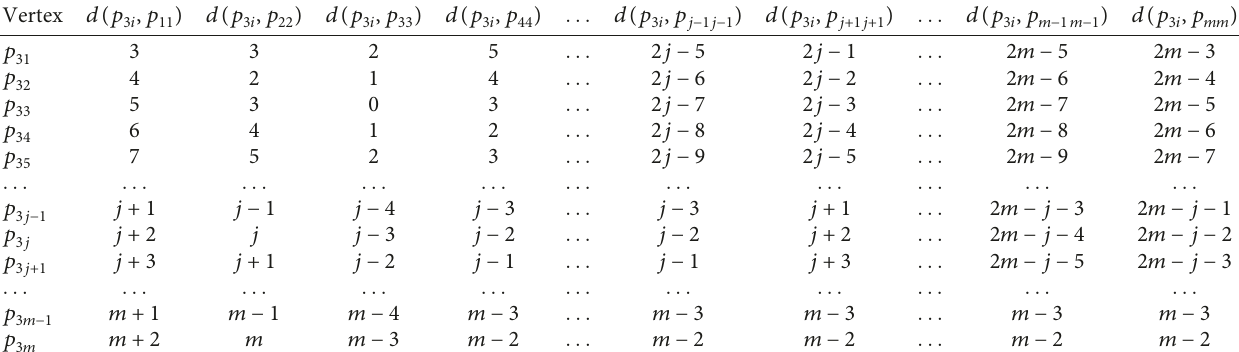
( M ) of vertices in the third cluster for 1 ≤ i ≤ m . p 3 i jj